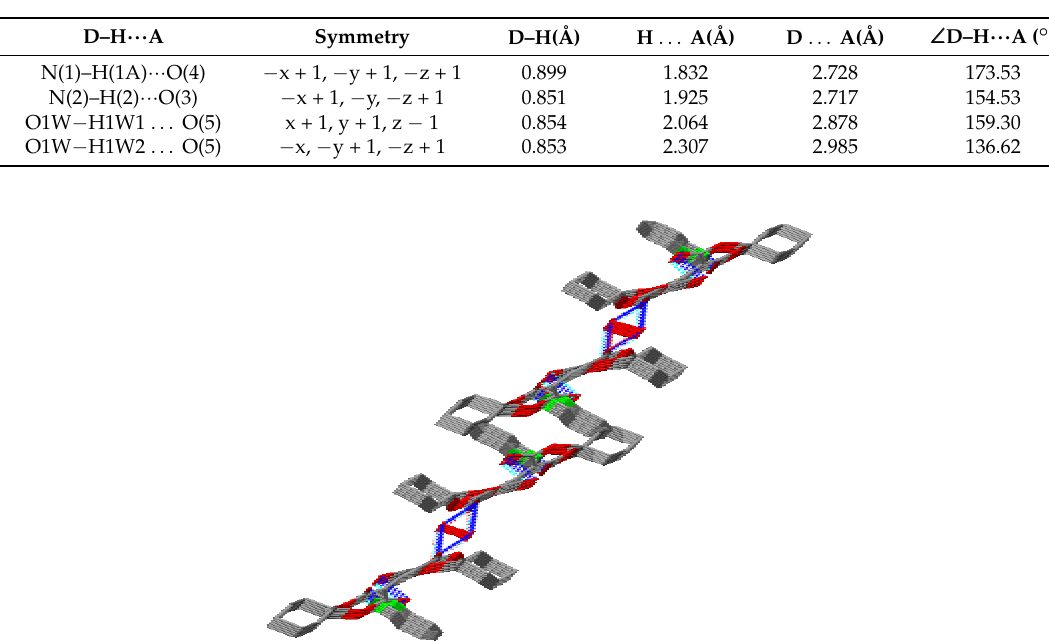
Figure 4. Three-dimensional (3D)-layered structure of (C 19 H 21 O 8 ) (C 7 H 7 N 2 ) (0.5H 2 Figure 4 . Three-dimensional ( 3D)-layered structure of (C 19 H 21 O 8 ) (C 7 H 7 N 2 ) (0.5H 2 O). Table 2. Hydrogen bond distances and angles for the title compound.